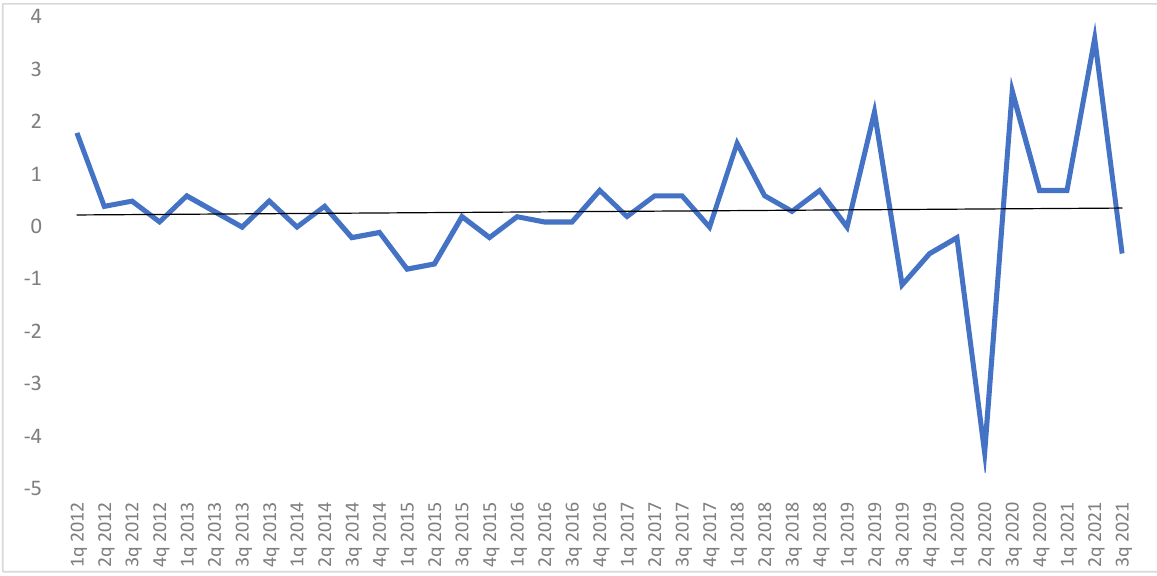
Figure 1. Growth dynamics of Russia’s GDP (2012–2020) (Russian GDP growth rates (q/q)). Source: Own visualization based on Trading Economics (2021).